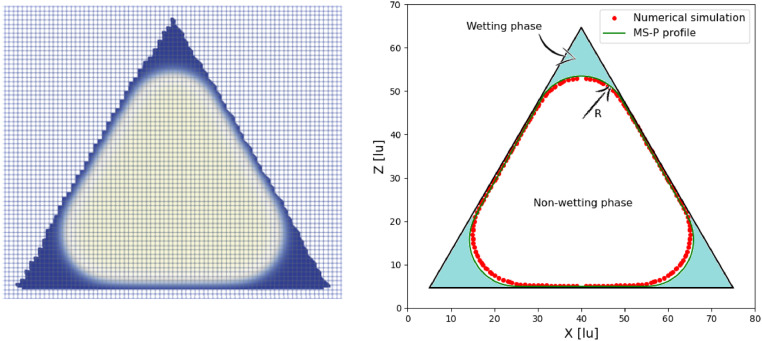
Staircased walls causing non-symmetry of the LBM solution (unequal filling of the corners).